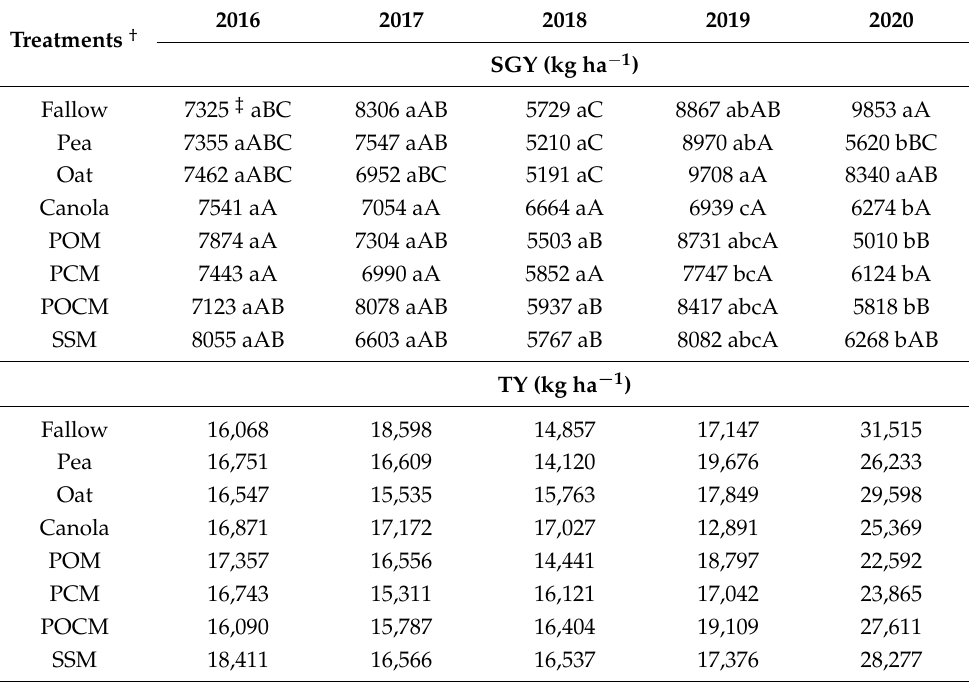
Inorganic N = 0.061x − 3.97; R² = 0.195; p = 0.004